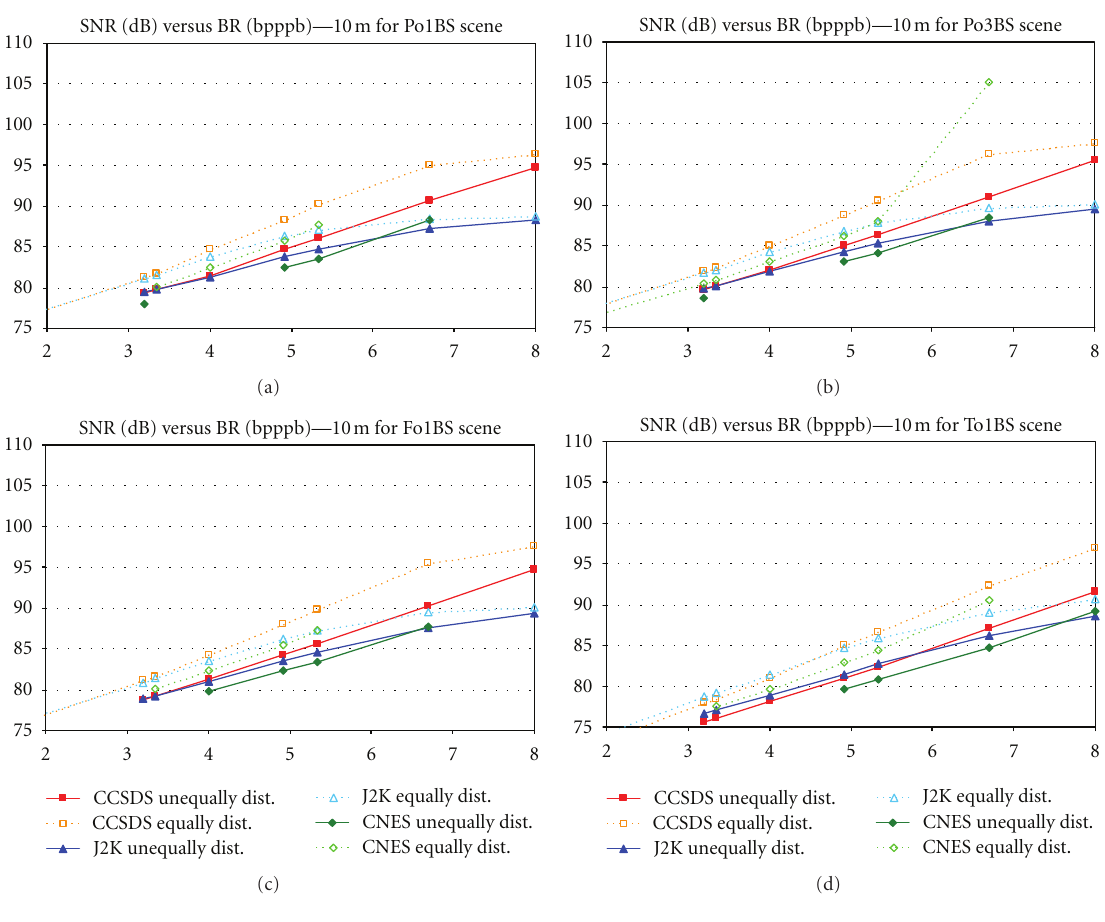
Figure 5: SNR (in dB) of 10m bands in relation to the bit rate (in bpppb) of all the compression algorithms for all scenes at high bit rates. Two strategies are used to divide the BR among bands (at each compression ratio): unequal or equal distribution. (Please note that the y -axis is not the same as in Figures 4 and 6.)